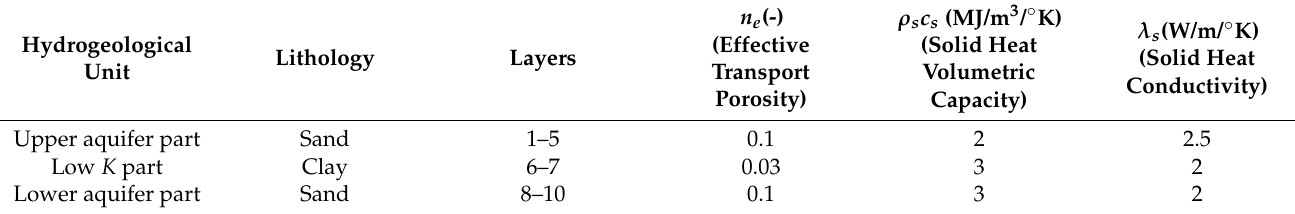
Figure 8. Observed and simulated temperatures in warm (WW) and cold (CW) wells of Building n ◦ 1 in scenario 1 (reference scenario). Table 2. Heat transport parameters values introduced in the model